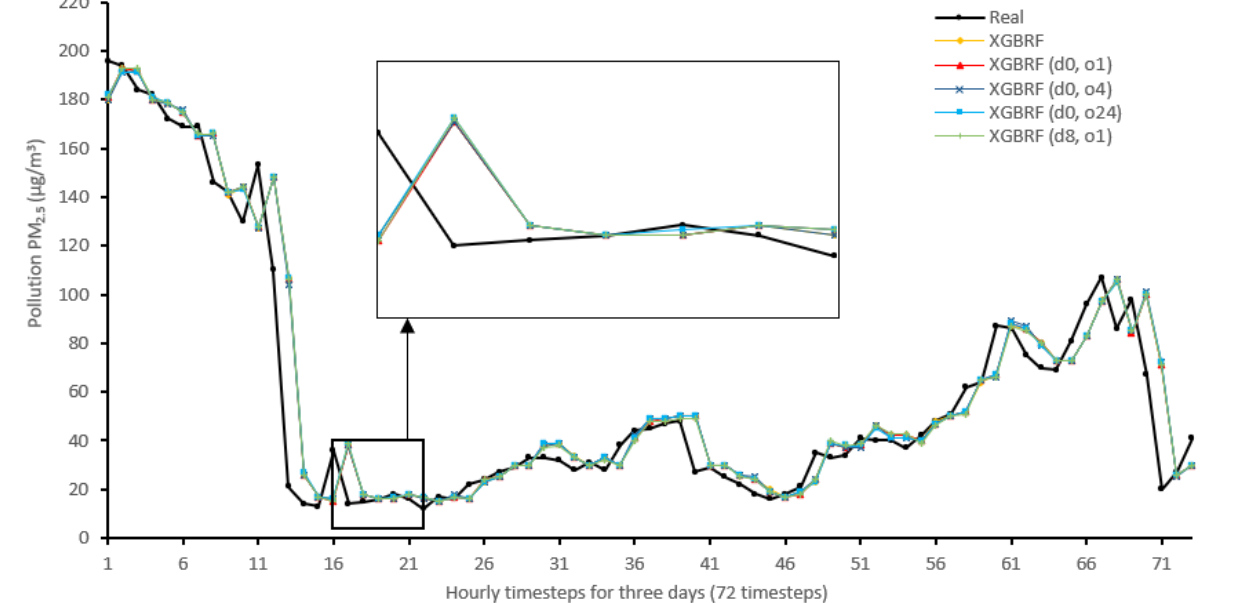
Figure 20. Real vs. XGBRF and its NARX variants in part of the seventh iteration results for the Beijing dataset.